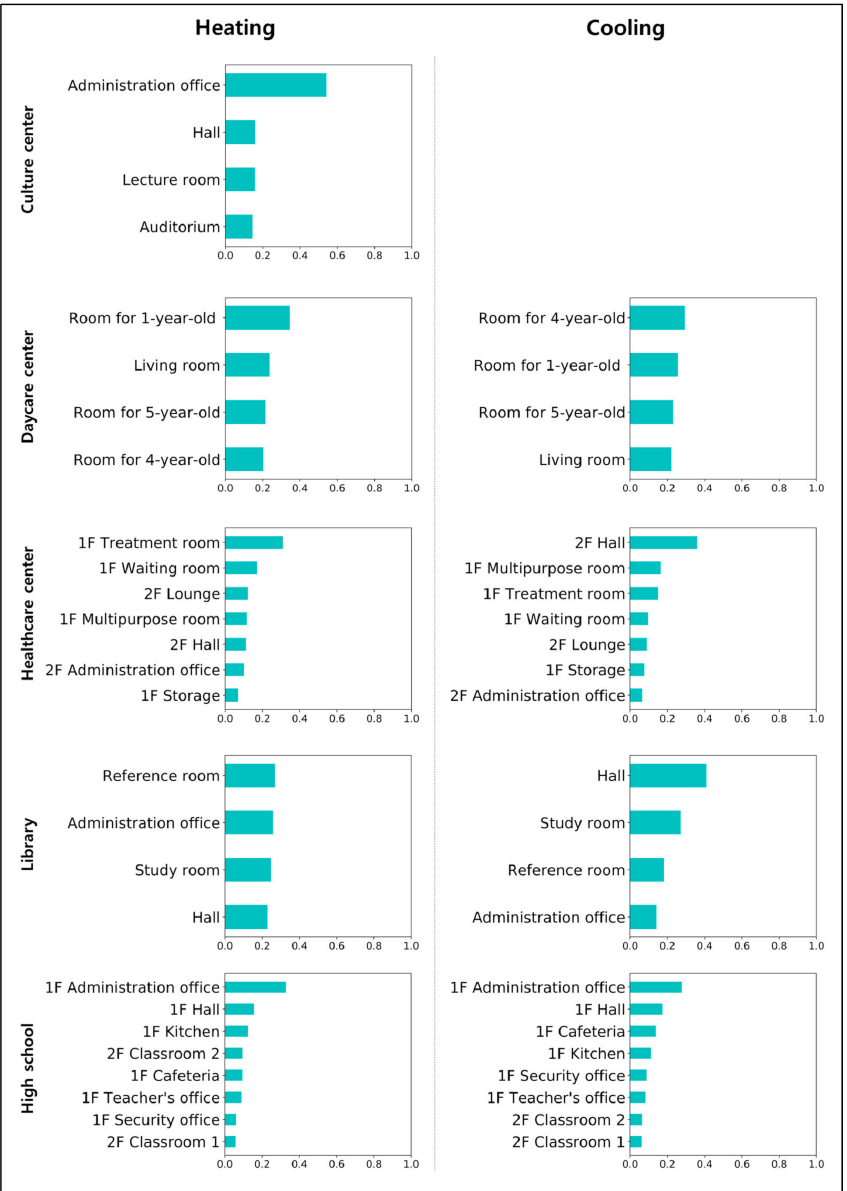
Figure 3. The results of prioritization using the Gini importance (indoor environmental